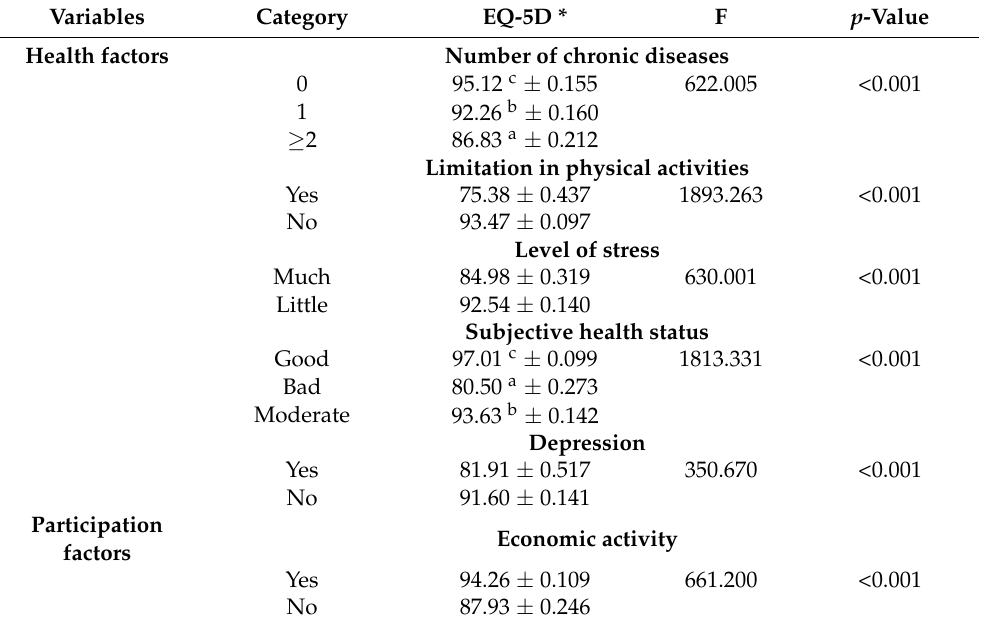
Table 3. Health-related quality of life according to active